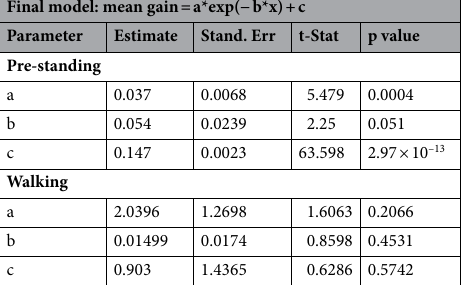
Table 1. Statistics for the parameter estimates of the two best fit exponential models. The first is during standing and the second during